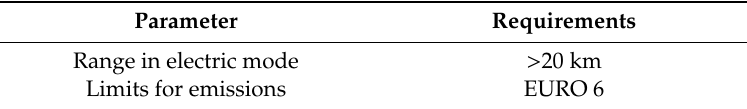
Table 3. Requirements of performance for the